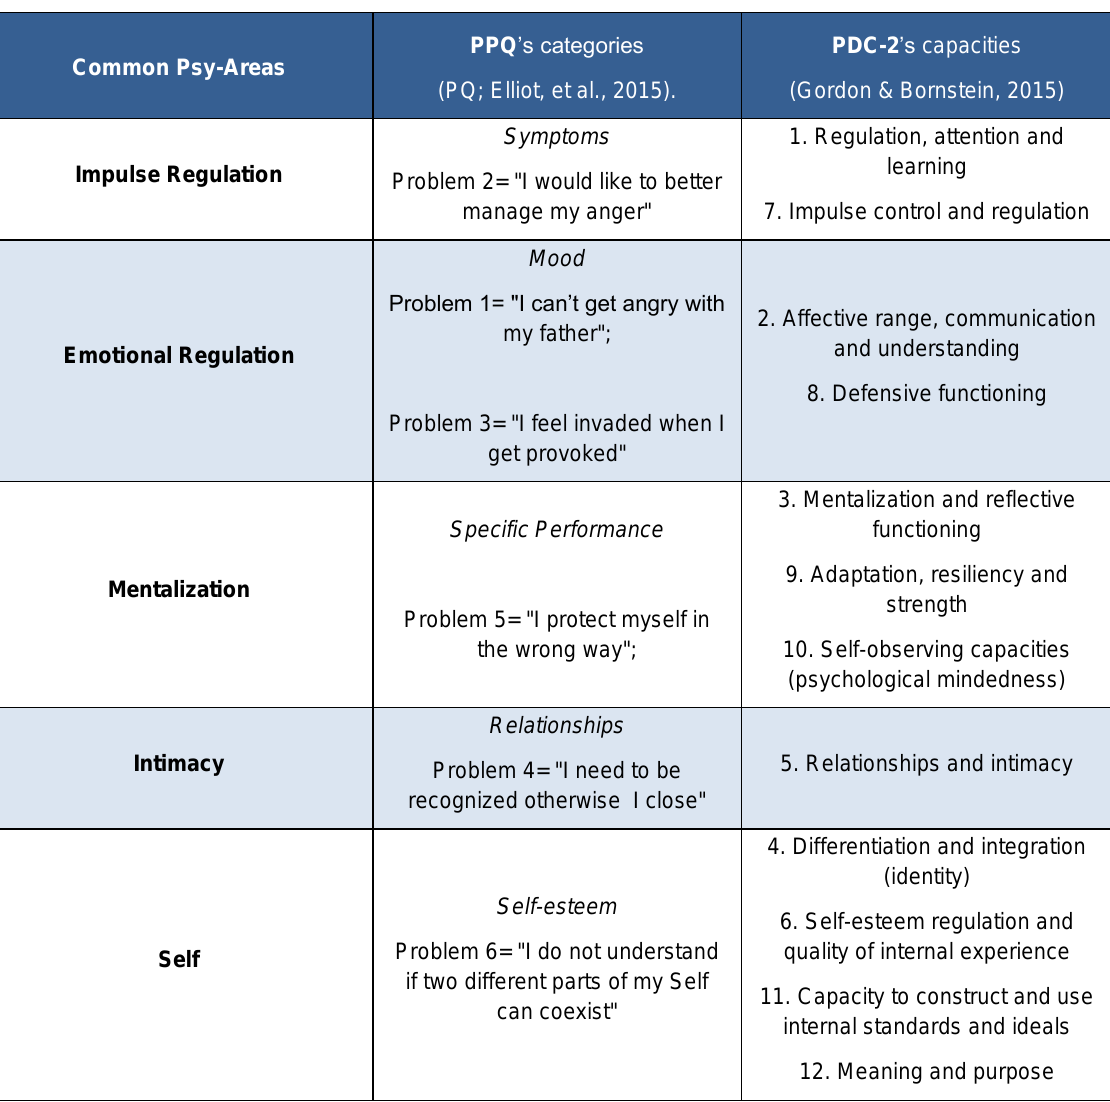
simplfied version (Elliot, 1999, Elliot et al., 2016;).